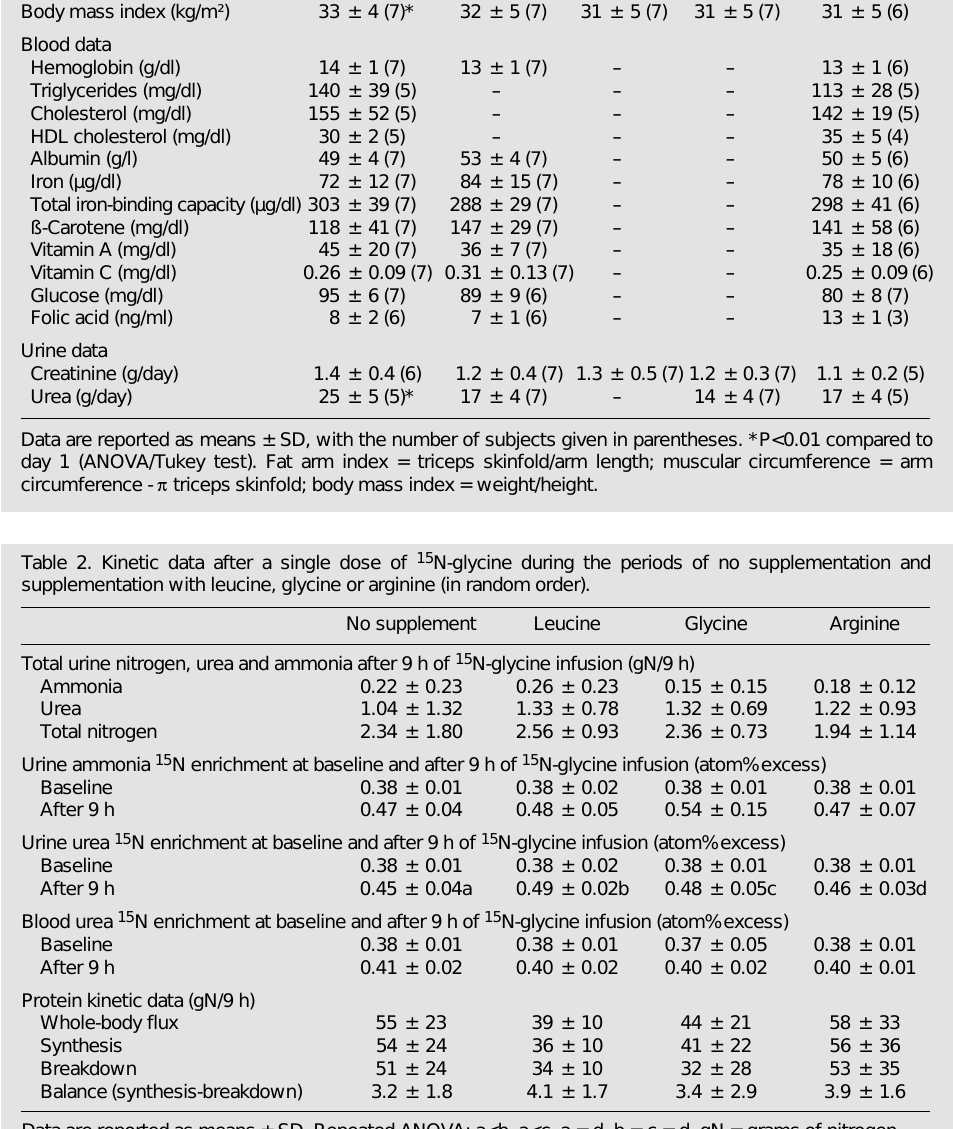
Experimental day